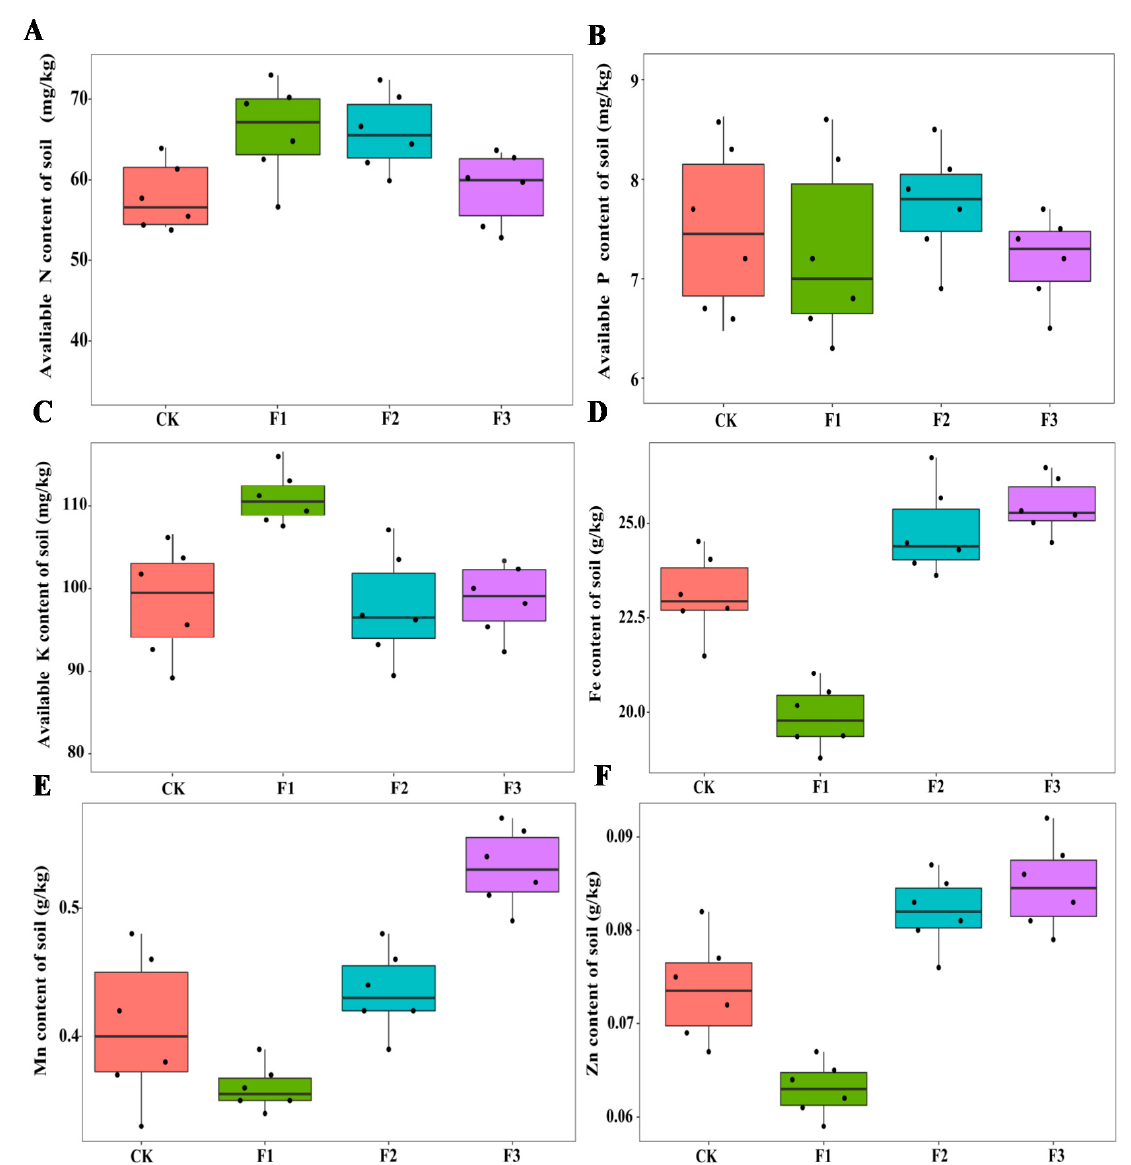
Figure 3. Effects of different foliar fertilizer on soil physicochemical properties of Chinese yam. Avaliable N content in rhizosphere soil of yam under different foliar fertilizer treatments ( A ); Avaliable P content in rhizosphere soil of yam under different foliar fertilizer treatments ( B ); Avaliable K content in rhizosphere soil of yam under different foliar fertilizer treatments ( C ); Fe content in rhizosphere soil of yam under different foliar fertilizer treatments ( D ); Mn content in rhizosphere soil of yam under different foliar fertilizer treatments ( E ); Zn content in rhizosphere soil of yam under different foliar fertilizer treatments ( F ). CK, spray with water; F1, NPK foliar fertilizer; F2, NPK+Fe-Mn-Zn foliar fertilizer; F3, Fe-Mn-Zn foliar fertilizer.